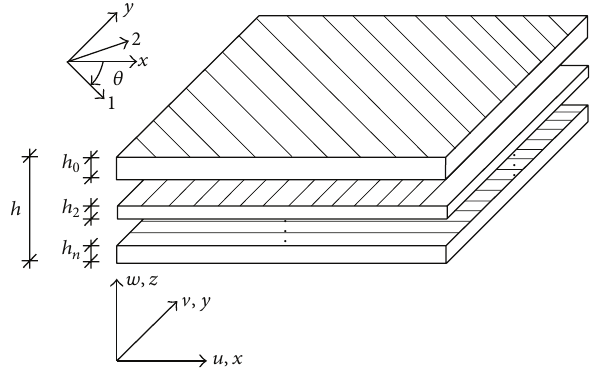
Figure 3: Detailed view of the anatomy of the composite ply